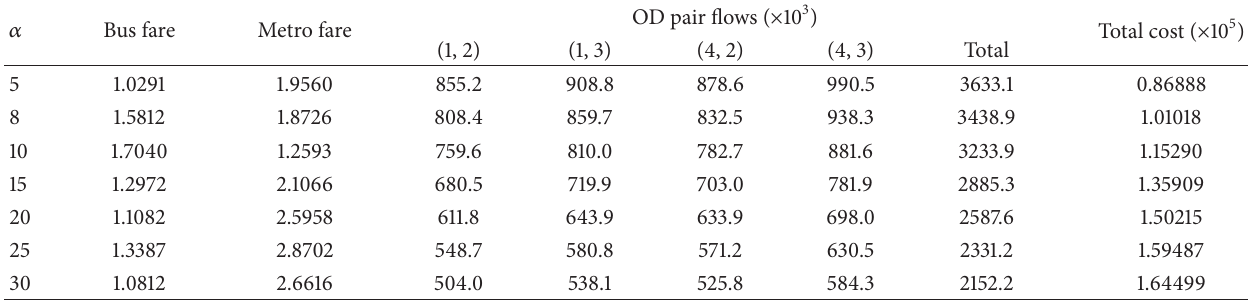
Table 6: Transit fare structure and transit route flows considering scenario 1 with different value of time.